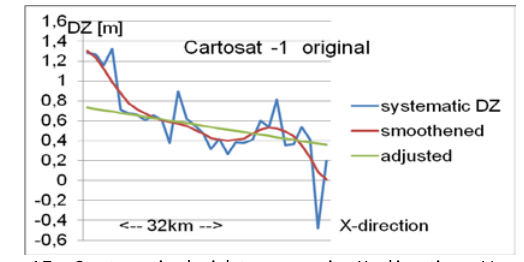
Fig. 17. Systematic height errors in X-direction, Warsaw, filtered Cartosat-1 DSM against reference DTM